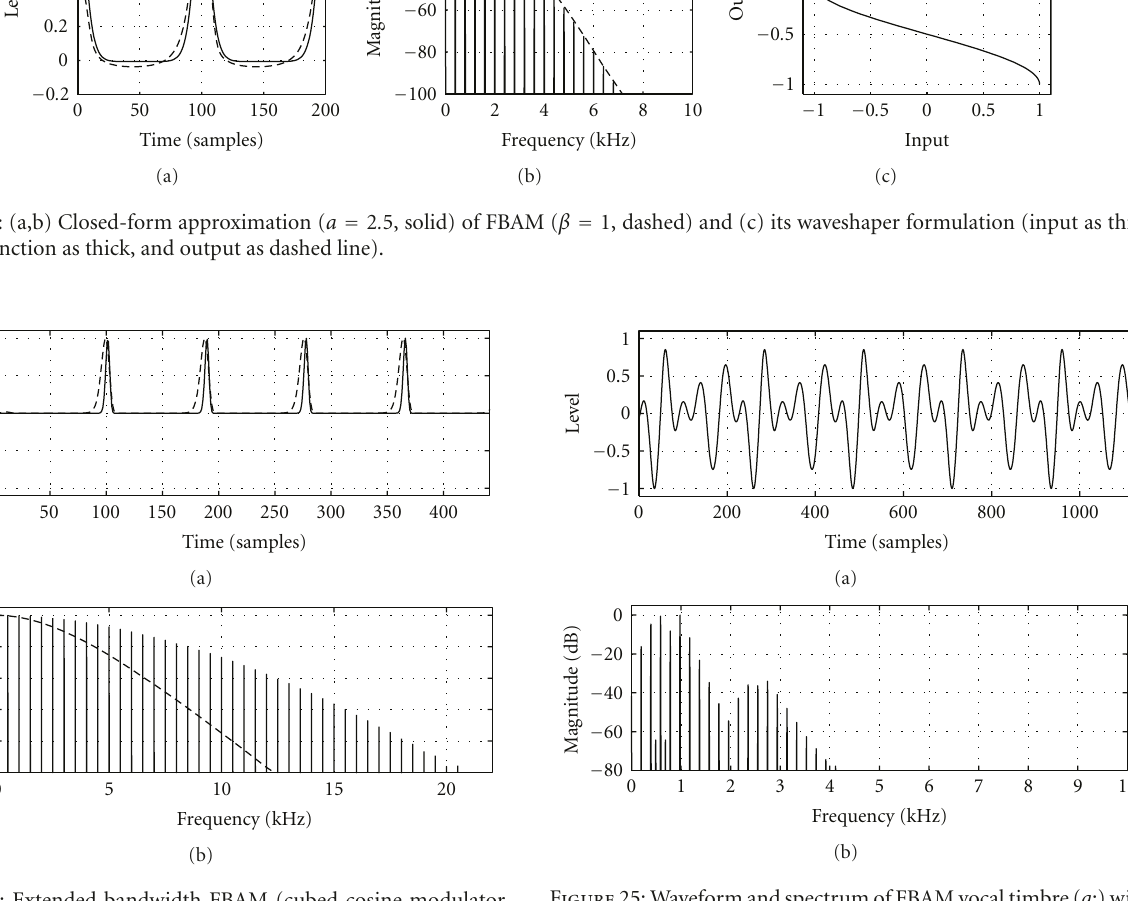
Figure 24: Extended bandwidth FBAM (cubed cosine modulator with β = 5 . 8, solid) and basic FBAM ( β = 1 . 5, dashed), with f 0 = 500Hz.